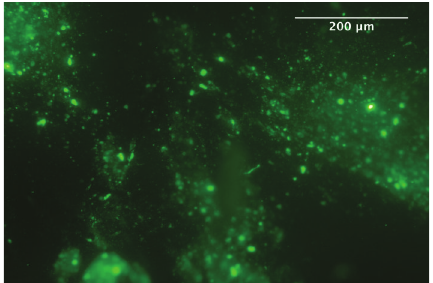
Figure 5: Q-Gel hydrogel with GFP expressing hMSCs (pmaxGFP) imaged with fluorescent microscope recovered from the center of the disc after 7 days of bovine intervertebral disc organ